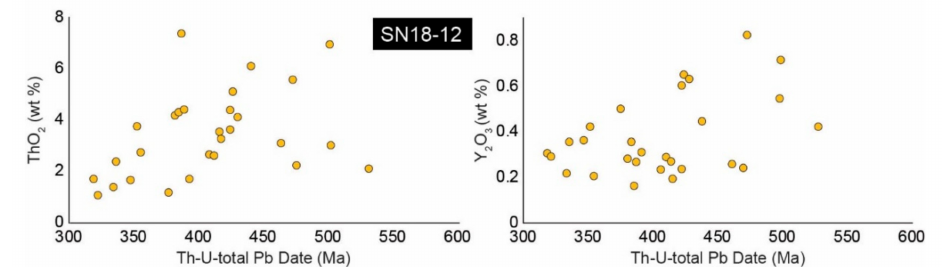
Figure 6. Monazite chemistry plots vs. Th-U-total Pb dates for ThO 2 (left side) and Y 2 O 3 (right side) for all three samples. No trends were observed for SN18-05A or ThO 2 vs. dates of sample SN18-06A. A slight decrease of Y 2 O 3 was observed with decreasing dates for sample SN18-06. The same trends were noted for both ThO 2 and Y 2 O 3 vs. dates for SN18-12.